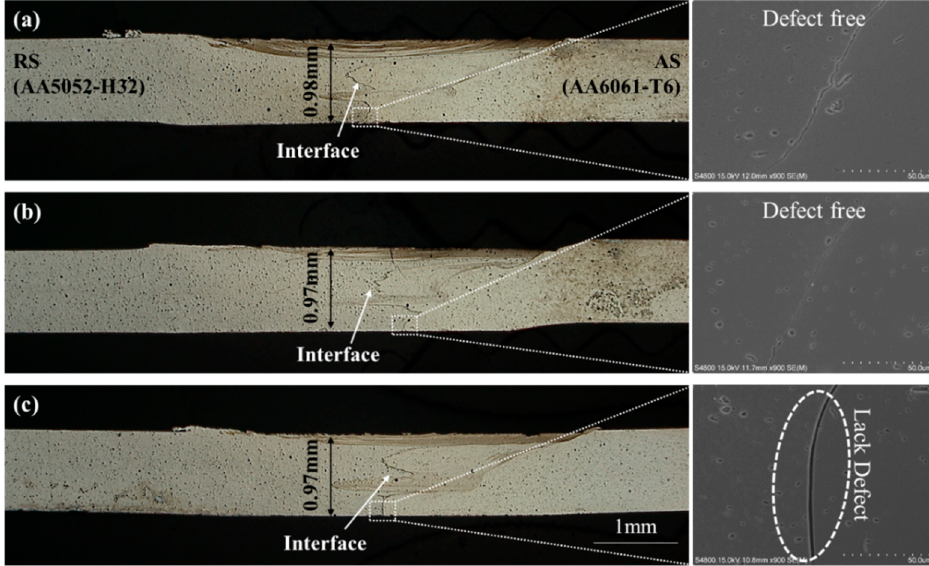
Figure 5. Optical microscopy (OM) images of the cross sections of the welding joints prepared using ( a ) cordierite, ( b ) Ti, and ( c ) Cu BP materials, where the insets are scanning electron microscopy (SEM) images of the bottom region, highlighting penetration defects.